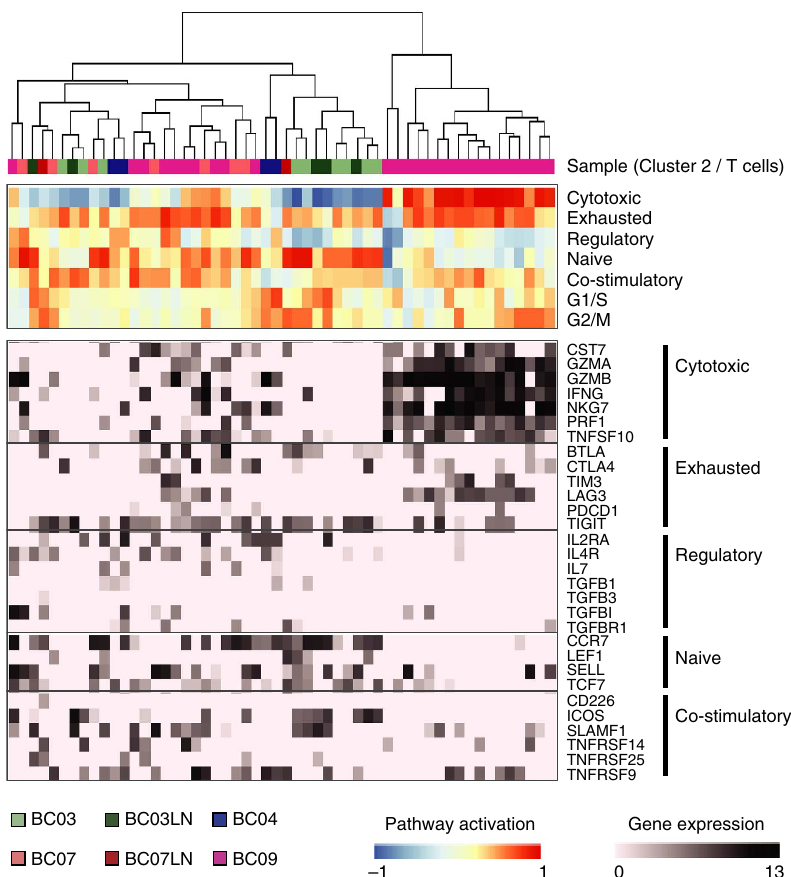
Figure 7 | T-cell signatures in the tumour microenvironment. Hierarchical clustering was performed using GSVA enrichment scores for gene sets for naive Tcells, T-cell costimulation, regulatory cytokines and receptors, T-cell exhaustion and cytotoxicity (upper panel). Specific genes from used gene sets are presented in the lower